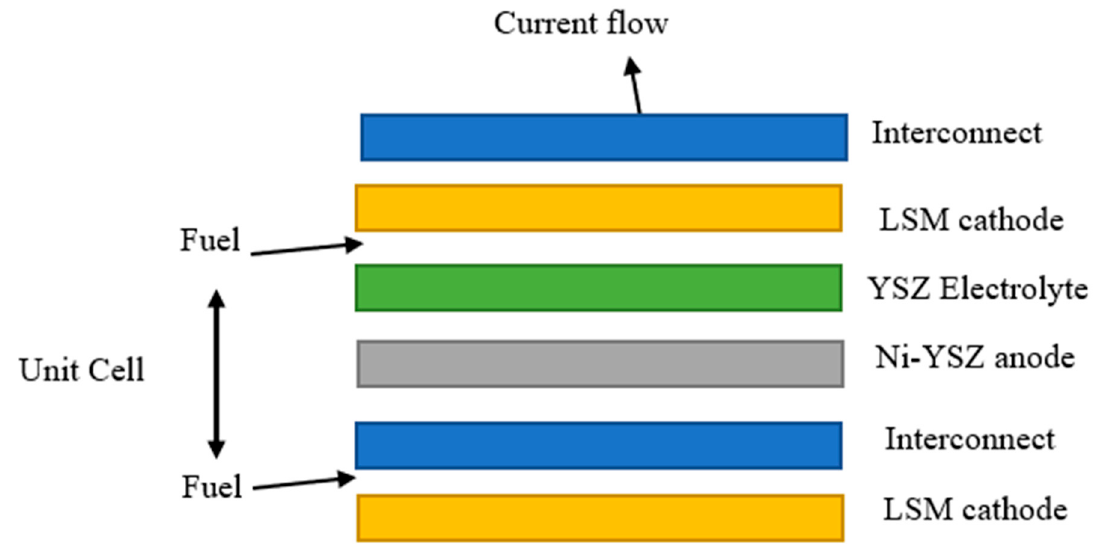
Figure 30. Schematic of a solid oxide fuel cell.